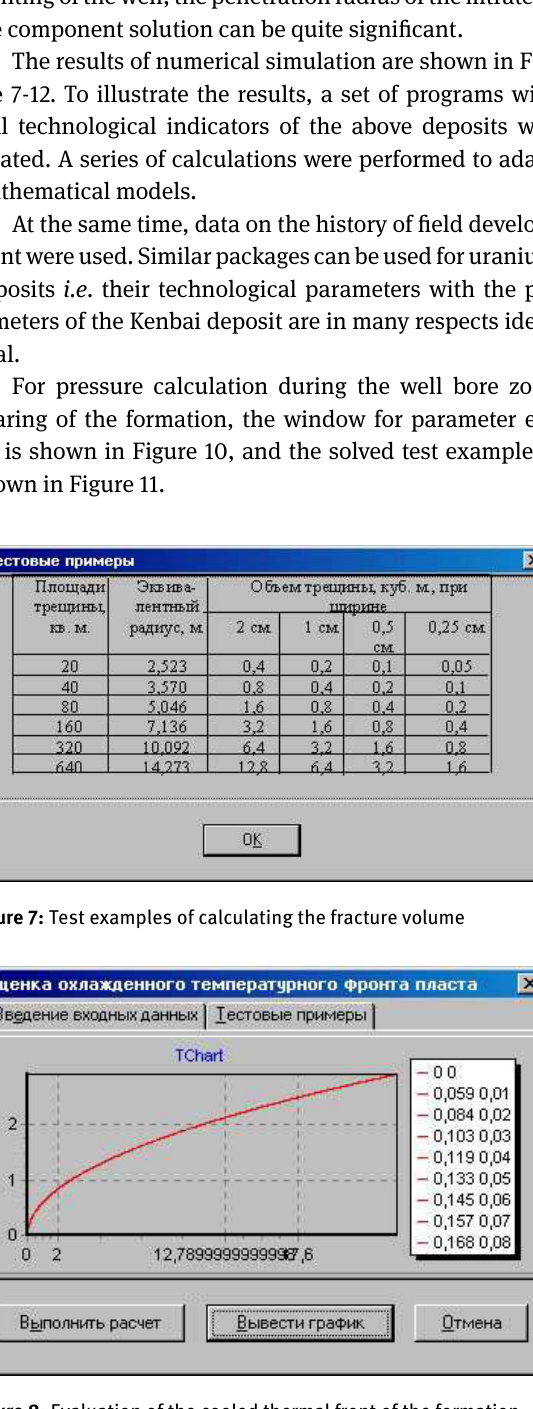
Figure 8: Evaluation of the cooled thermal front of the